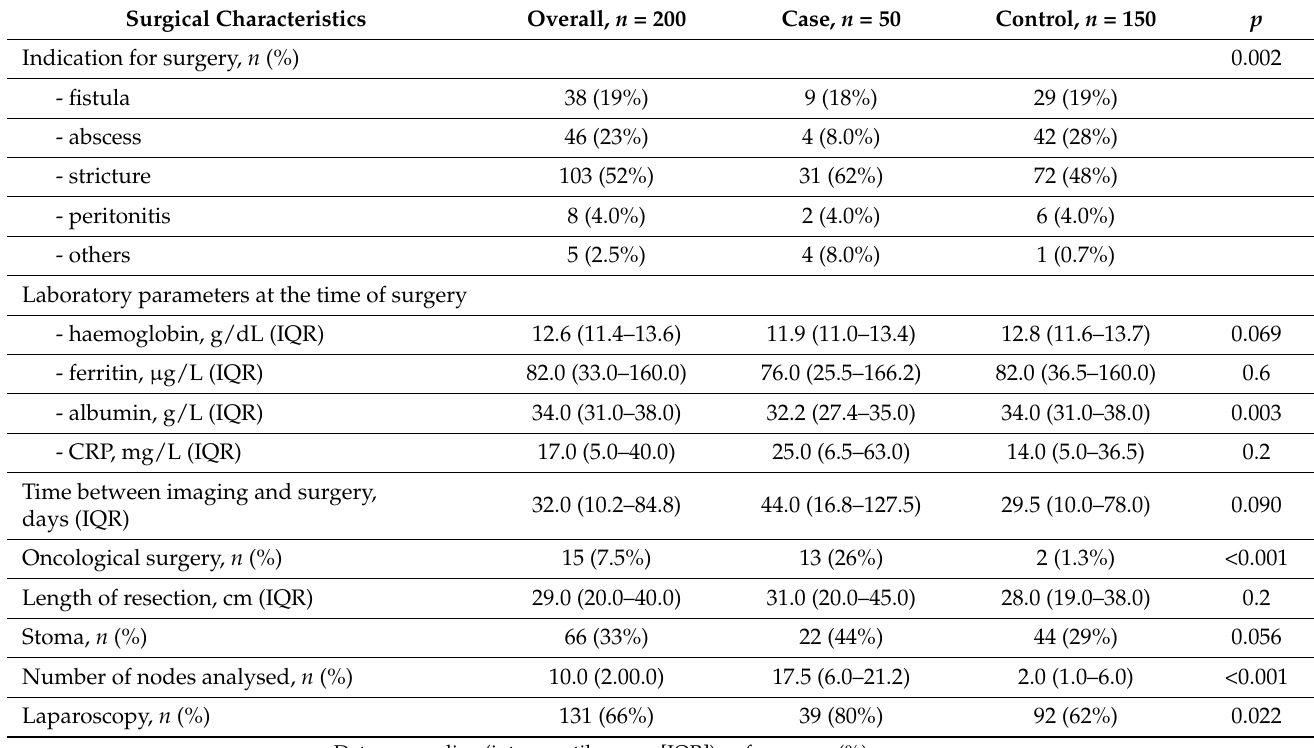
Table 2. Details of surgical procedures in the two subgroups.